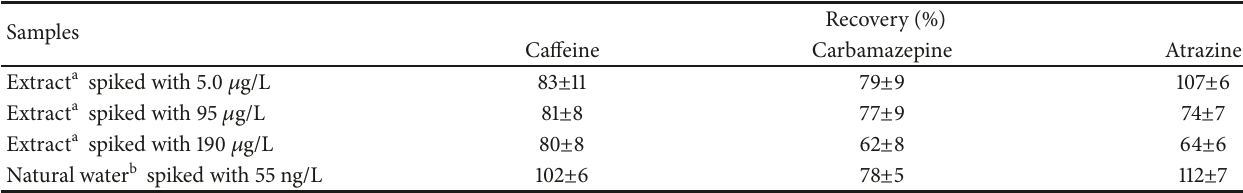
Table 6: Concentrations of caffeine, carbamazepine, and atrazinein the currentwater sources of the Brazilian Federal District and in selected tributaries. Analytes